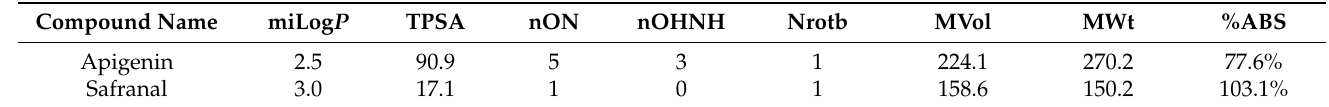
Table 2. Anticipated physiochemical characteristics of apigenin and safranal as putative 5HT2AR and 5HT1AR inhibitors and agonists,